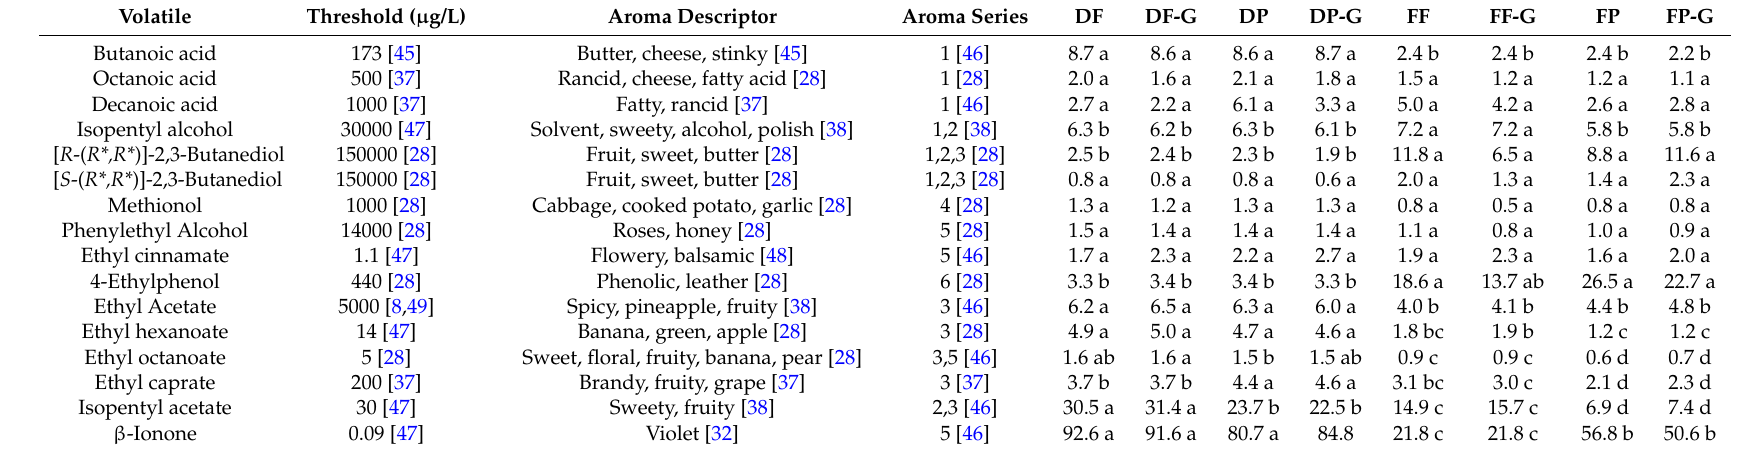
Table 5. Odor activity value (OAVs) of volatile compound in goji berry fermented